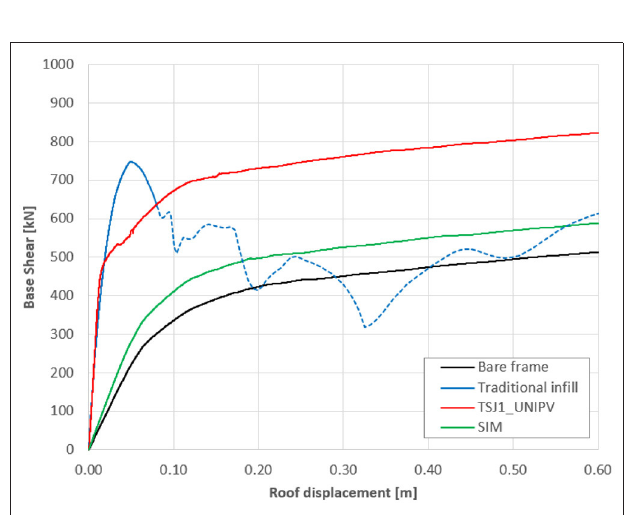
FIGURE 23 | Capacity curves for the bare and infilled (innovative and traditional systems) frames.